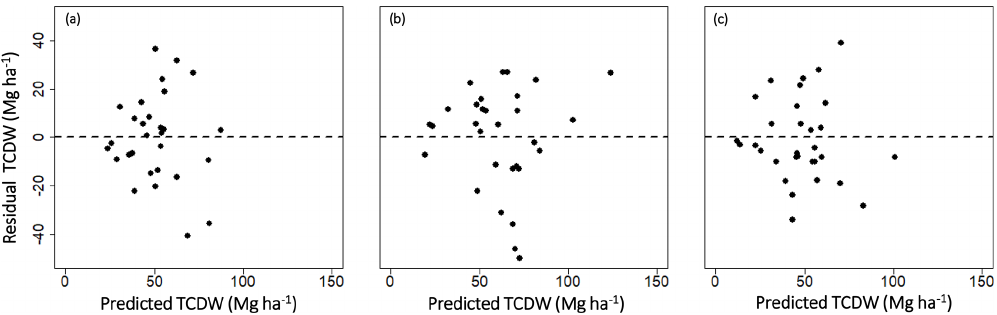
Figure 4. Residuals versus predicted values of total CDW (TCDW) by the models for lidar-only scenario for forests classified as (a) intact